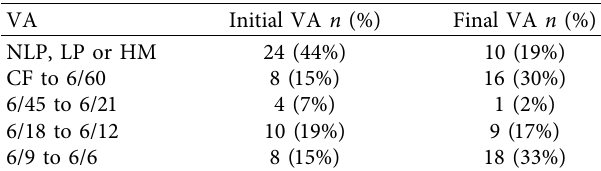
Table 2: Initial and final